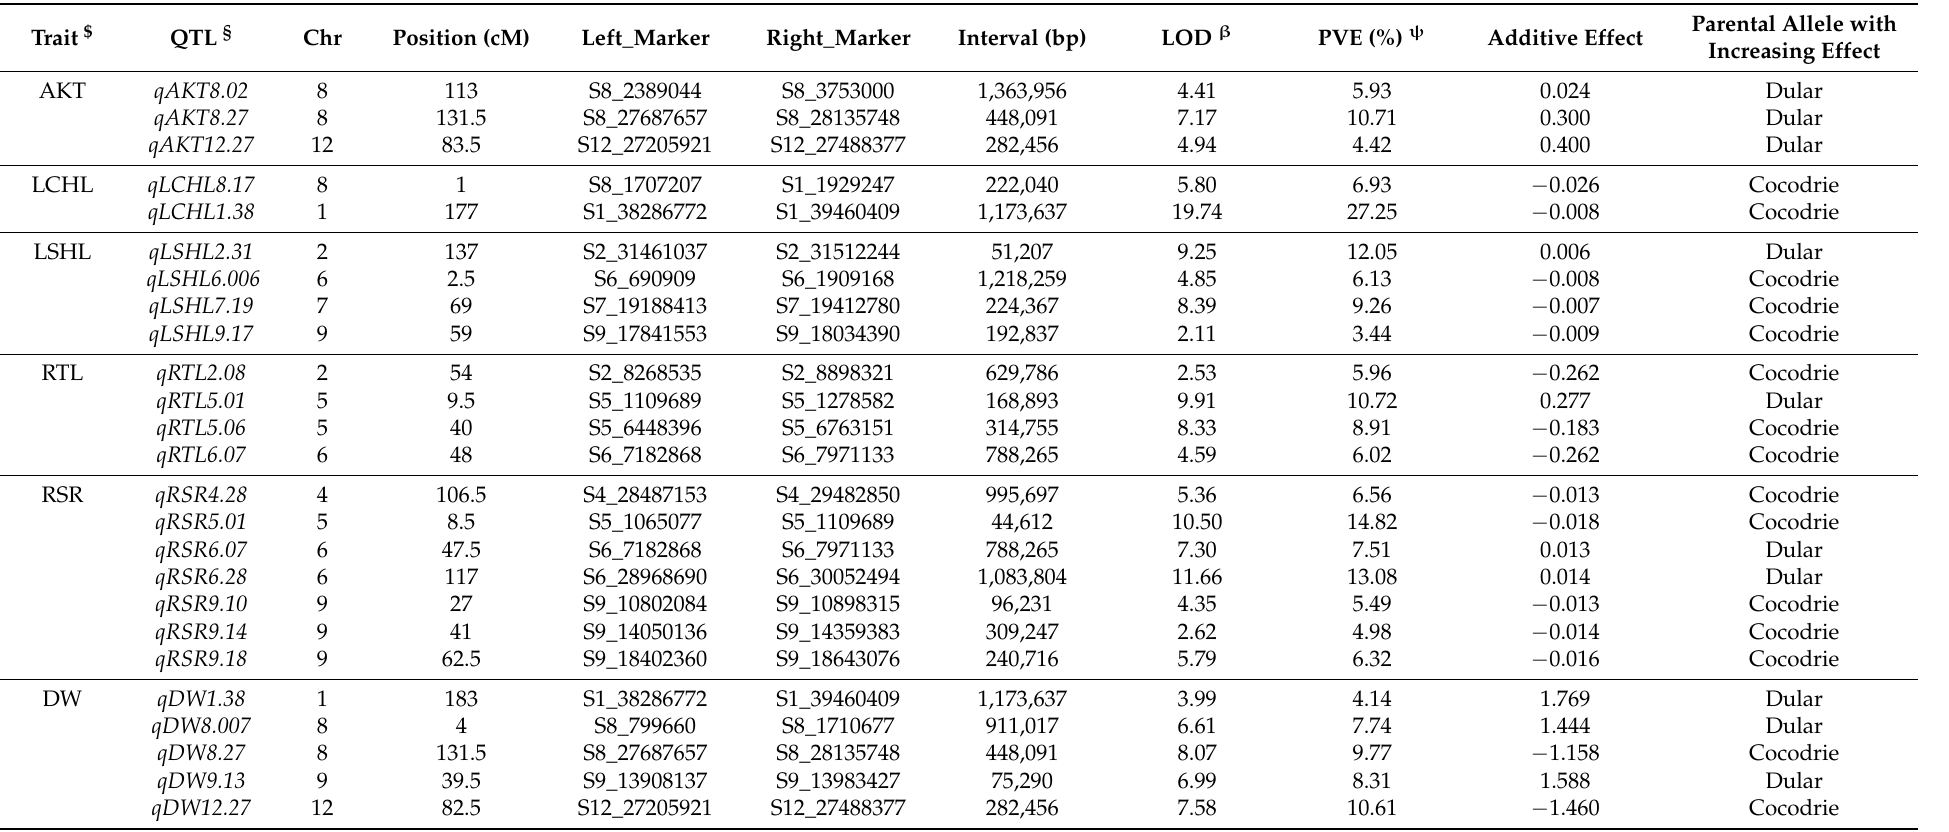
Table 4. Additive QTLs for traits related to alkaline tolerance at seedling stage in Cocodrie × Dular RIL population identified by ICIM